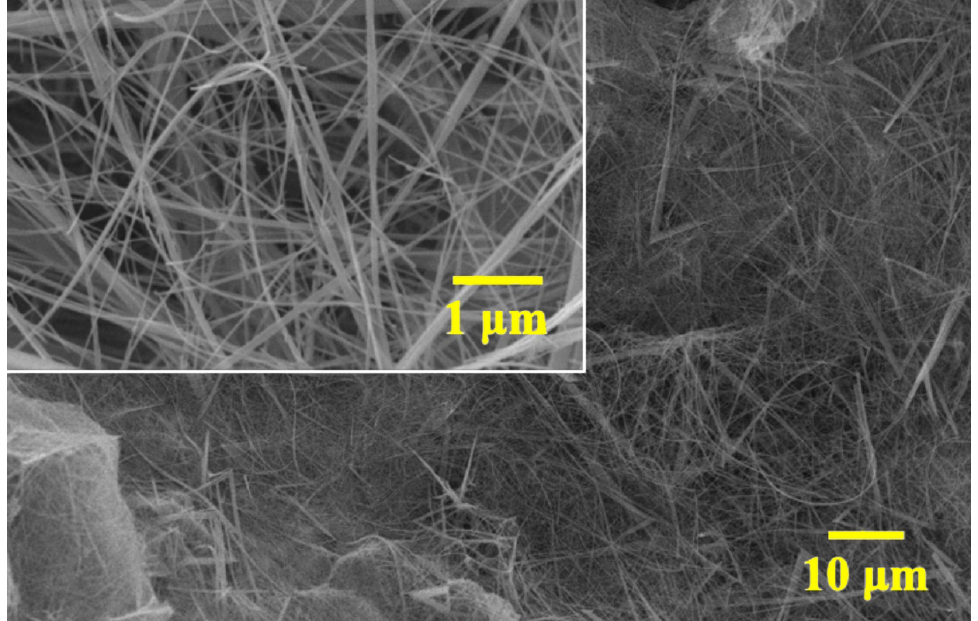
Figure 1. SEM image of α -MnO 2 nanowires hydrothermally synthesized at 180 ° C for seven days.